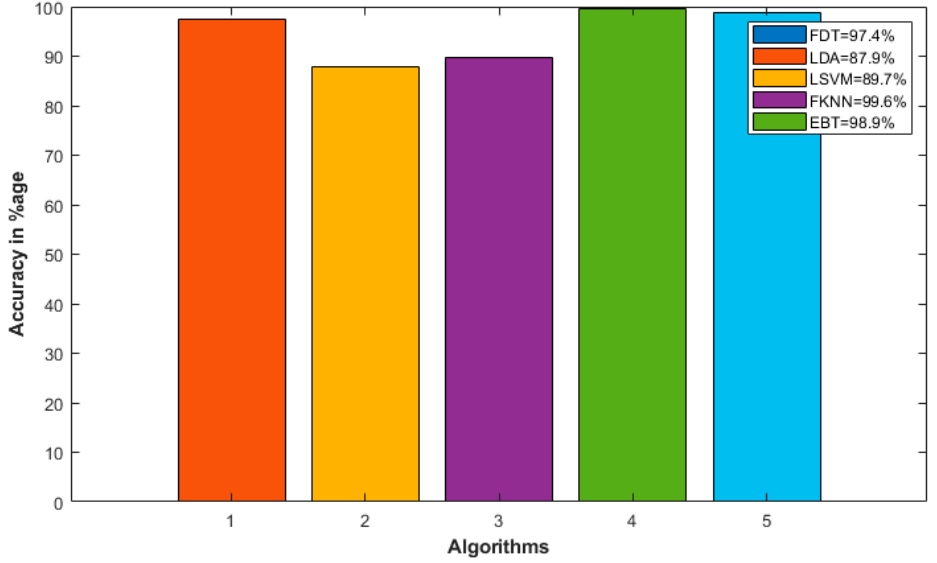
Chart 1. Accuracy of machine learning algorithms model.